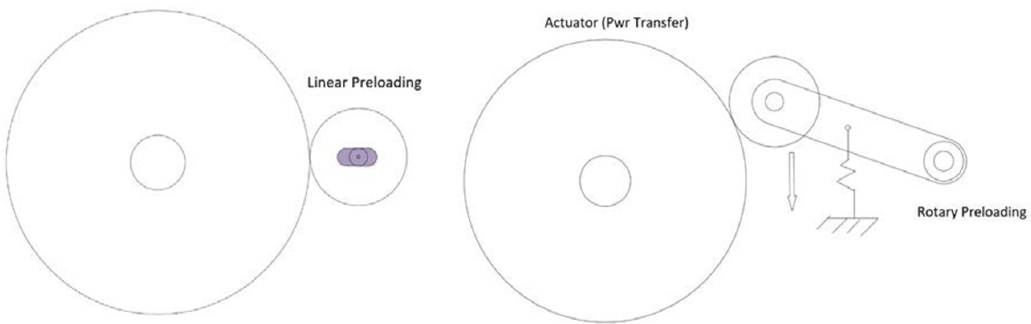
Figure 2. Two methods of preloading a friction drive transmission.